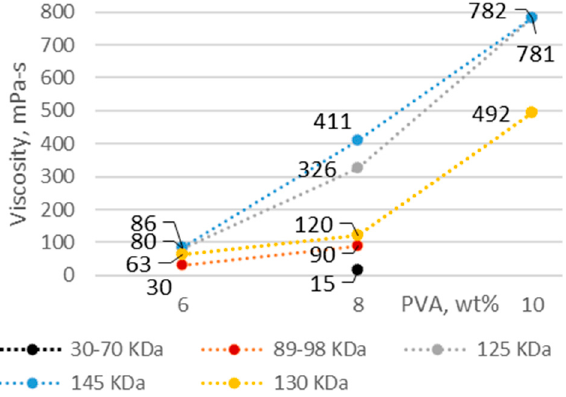
Figure 1. The viscosity parameters of spinning solutions depending on the concentration and molecular weight of polyvinyl alcohol.